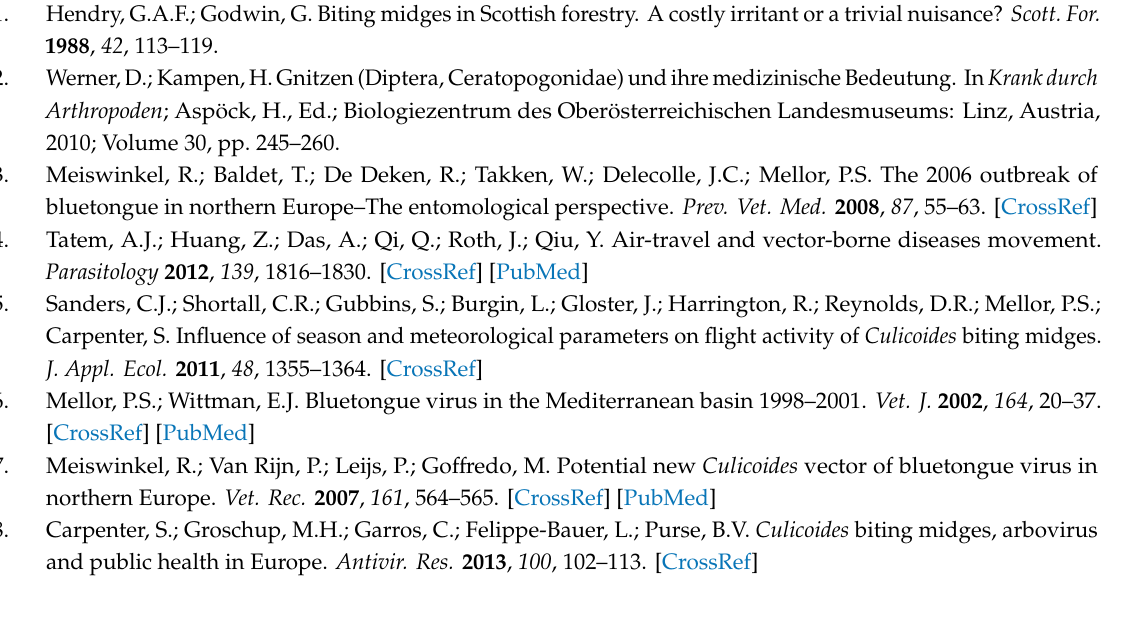
Table S1: Detailed list of sites, locations, study regions and landscape / habitat types sampled for emerging adult biting